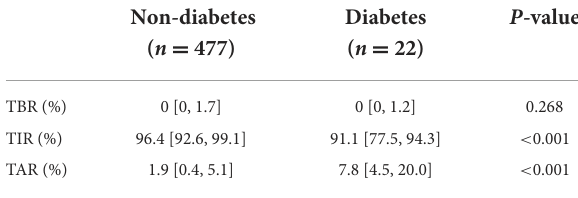
TABLE 2 Baseline clinical characteristics of subjects according to the development of type 2 diabetes after 5-years follow-up.